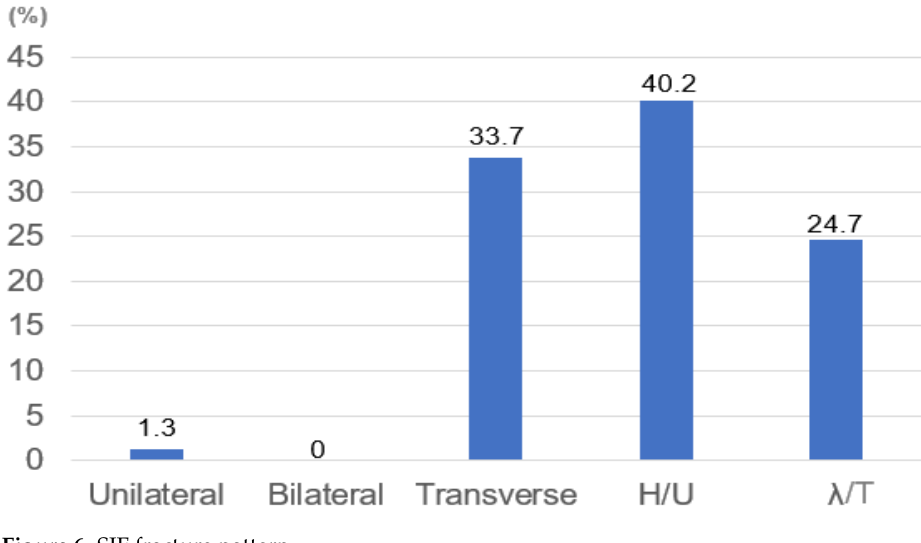
Figure 6. SIF fracture pattern.